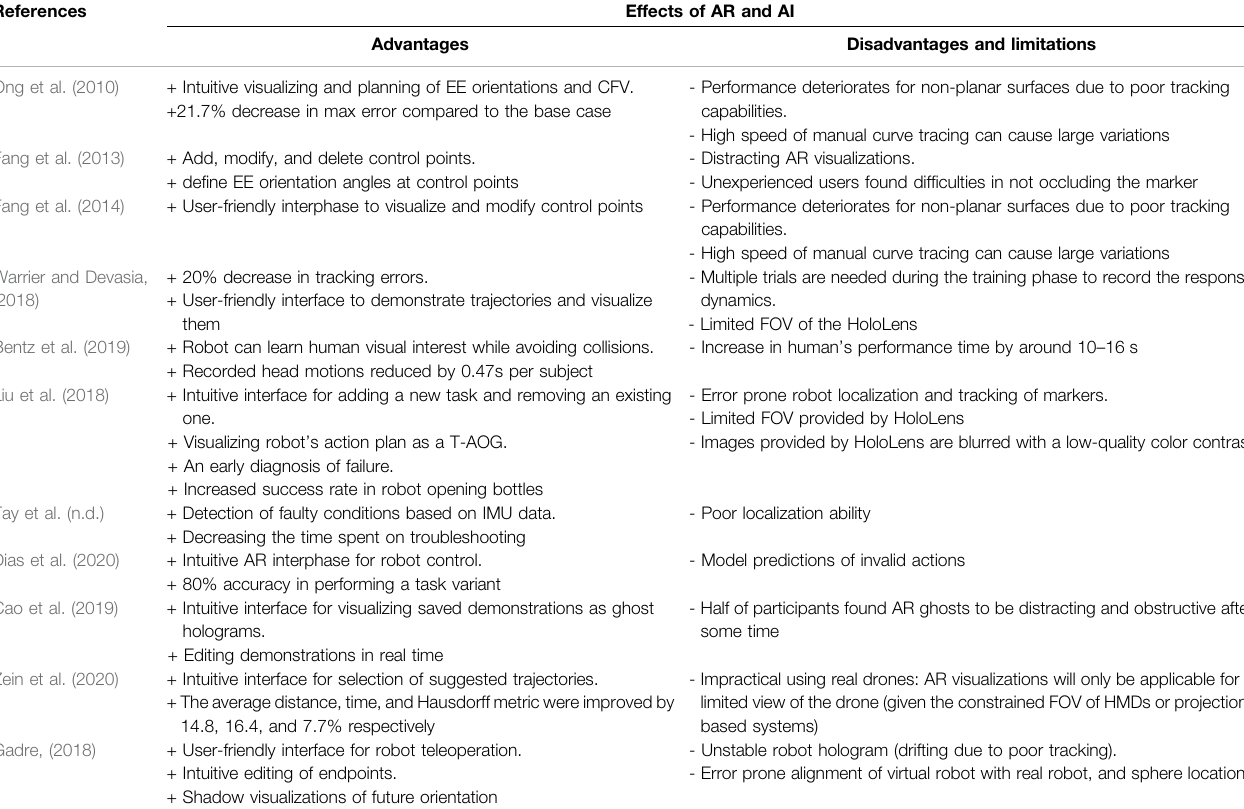
TABLE 3 | The advantages as well as the disadvantages and limitations of each method in the Learning